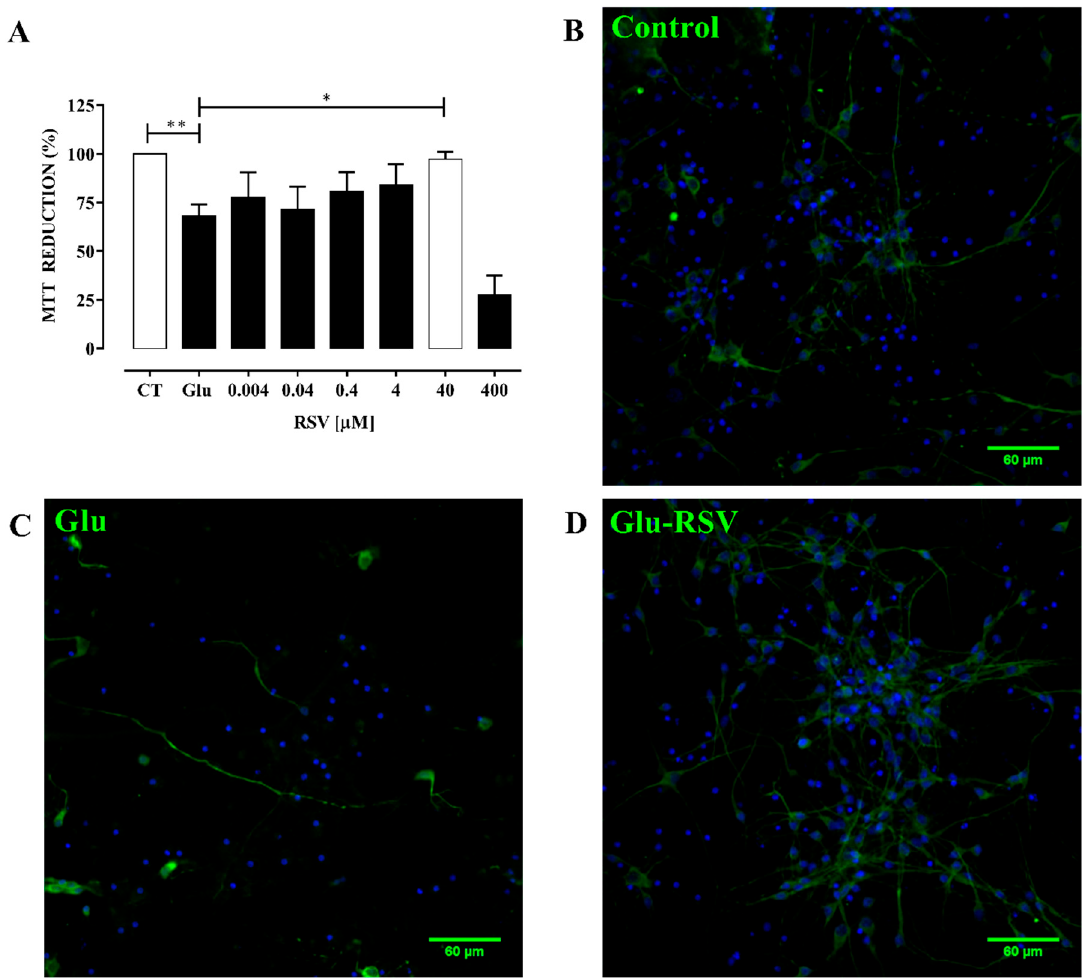
Figure 1. Resveratrol (RSV) protects against damage induced by excitotoxicity in cultured neurons. ( A ) RSV dose-response. Primary neuronal cultures were stimulated with 100 µ M glutamate (Glu) for 10 min to induce excitotoxicity. RSV was diluted in ethanol (0.05%). After excitotoxicity, cultured neurons were treated with di ff erent concentrations of RSV during 24 h. CT, control cultures not stimulated with Glu. Glu, cultures subjected to excitotoxicity not treated with RSV. Percentage of viability was evaluated 24 h after excitotoxicity by 3-(4,5-dimethylthiazol-2-yl)-2,5-diphenyltetrazolium bromide (MTT) reduction. Results were expressed as mean ± SEM; ANOVA, n = 4. Di ff erence was found between CT vs. Glu, ** p < 0.001; and Glu vs. Glu-RSV 40 µ M (white bar), * p < 0.05. Representative images of neuronal cultures are showed in ( B ) Control. Neuronal culture under control conditions. ( C ) Glu. Neuronal culture exposed to excitotoxicity. ( D ) Glu-RSV. Culture expose to excitotoxicity and 40 µ M RSV added at the onset of recovery. Condensates nuclei were detected by immunofluorescence microscopy with Hoechst 33342 (blue) and neurons were identified with the antibody anti-Microtubule-Associated Protein 2 (MAP-2, green).